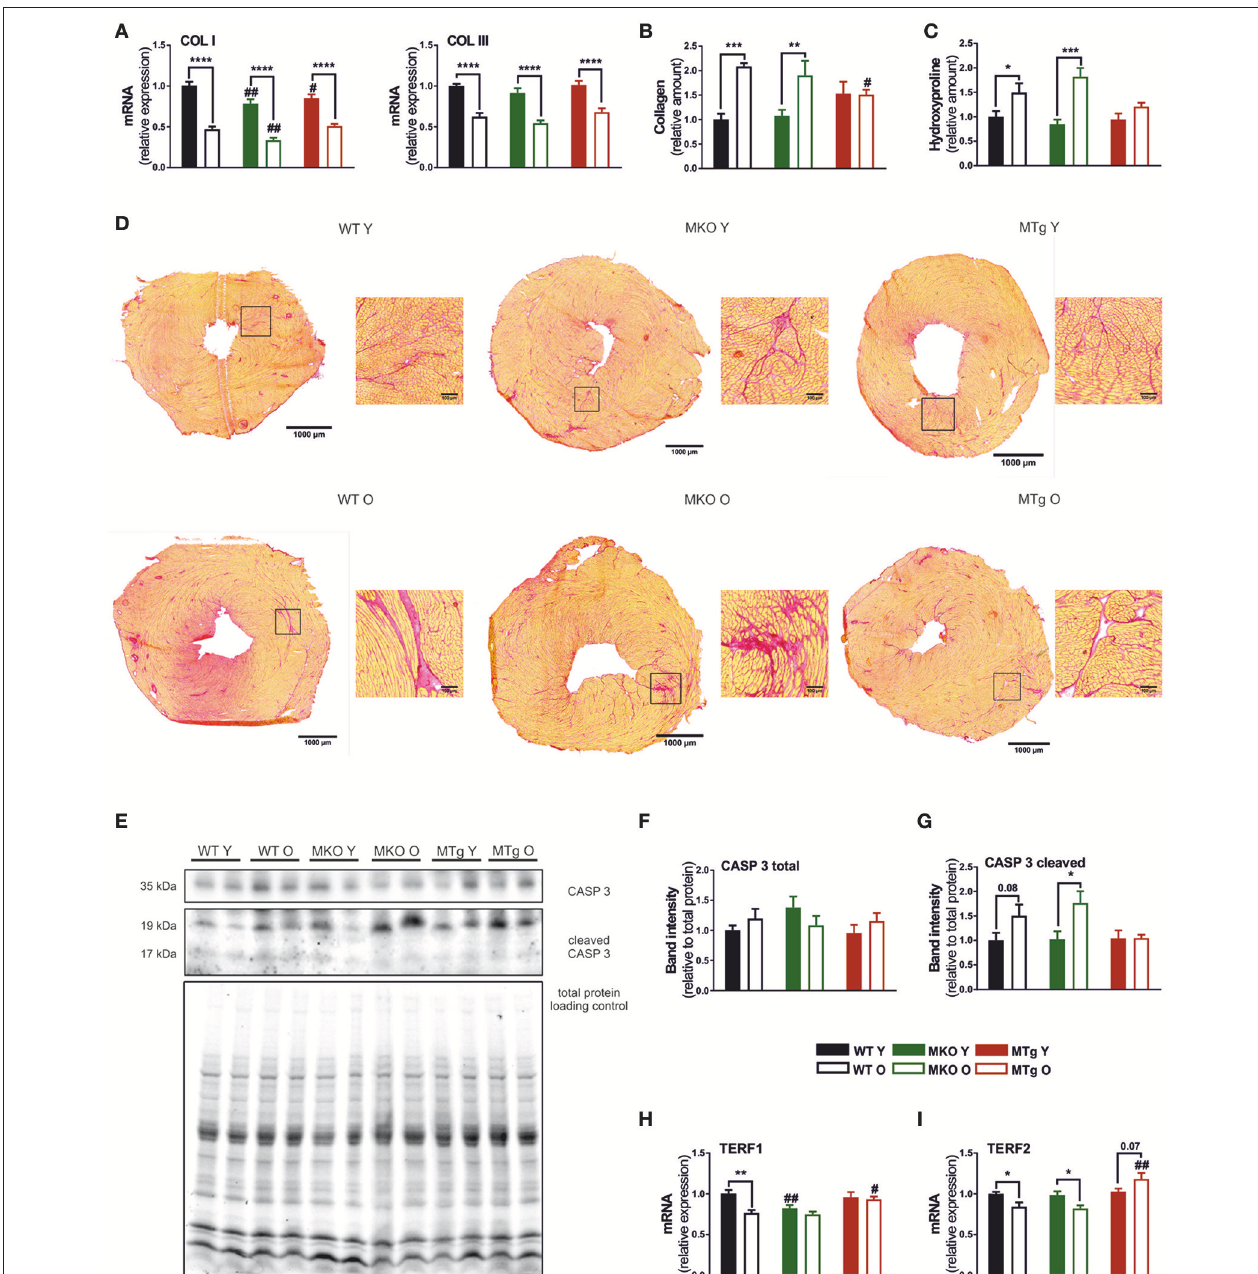
FIGURE 2 | PGC-1 α overexpression reduces age-dependent collagen accumulation and the age-induced expression of telomere-modulating genes. (A) Gene expression of collagen type I and III ( n = 6/group). (B) Relative collagen content measured with Picrosirius Red staining ( n = 5–6/group). (C) Relative content of hydroxyproline measured with hydroxyproline assay ( n = 6/group). (D) Picrosirius Red staining done on 8 µ m thick cryosections, red indicates collagen. (E) Western blot of caspase 3 and cl. caspase 3, normalized to total protein loading control. Western blot quantification ( n = 6/group) of (F) caspase 3 and (G) cleaved caspase 3 ( n = 6/group). (H,I) Expression of TERF1 and TERF2 mRNA ( n = 6/group). Data are means ± SEM of values from each group. Significant age/genotype-associated differences ( p < 0.05) are indicated by asterisks (*) and by hashtags (#, compared to WT) respectively (*/#: p < 0.05; **/##: p < 0.01; *** p < 0.001; **** p < 0.0001 indicates age/genotype related significant differences). CASP, caspase; COL, collagen; O, old; TERF, telomeric repeat-binding factor; Y, young.